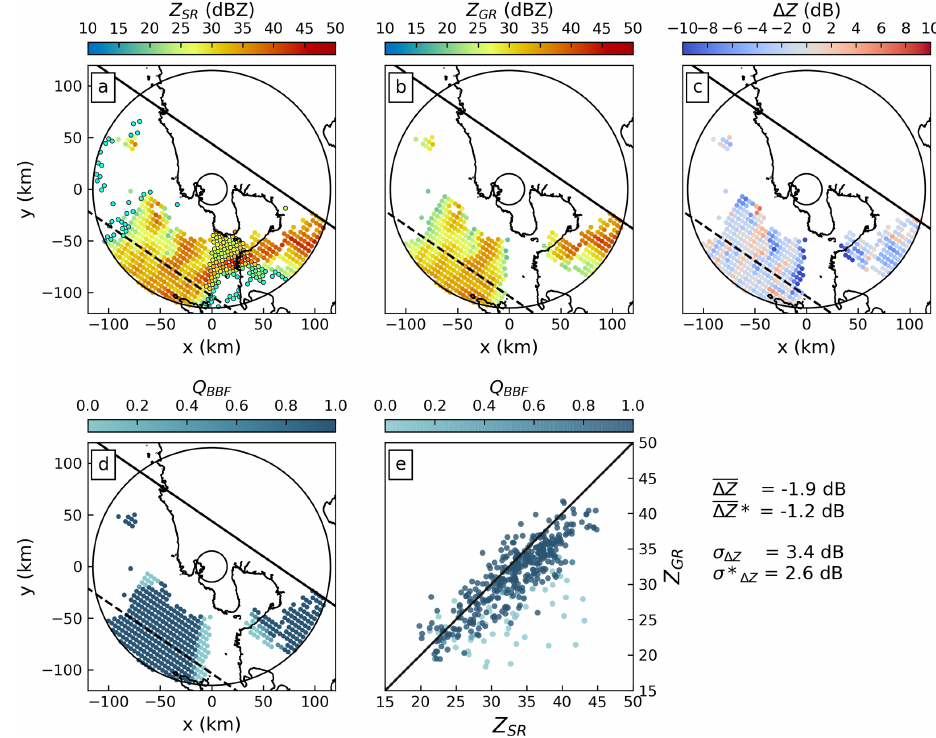
Figure 5. GR-centered maps of volume-matched samples from 8 November 2013 at a 0.5 ◦ elevation angle of (a) SR reflectivity, (b) GR reflectivity, (c) difference between GR and SR reflectivities, and (d) Q BBF . (e) Scatter plot of Z GR versus Z SR where each point is coloured based on the data quality ( Q BBF ). The solid line in (a) – (d) is the edge of the SR swath; the other edge lies outside the figure. The dashed line denotes the central axis of the swath. The solid concentric circles demarcate the 15 and 115km ranges from the radar. In (a) observations that are present in the SR data but not detected by the GR are encircled in black. The mean bright band is at a height of